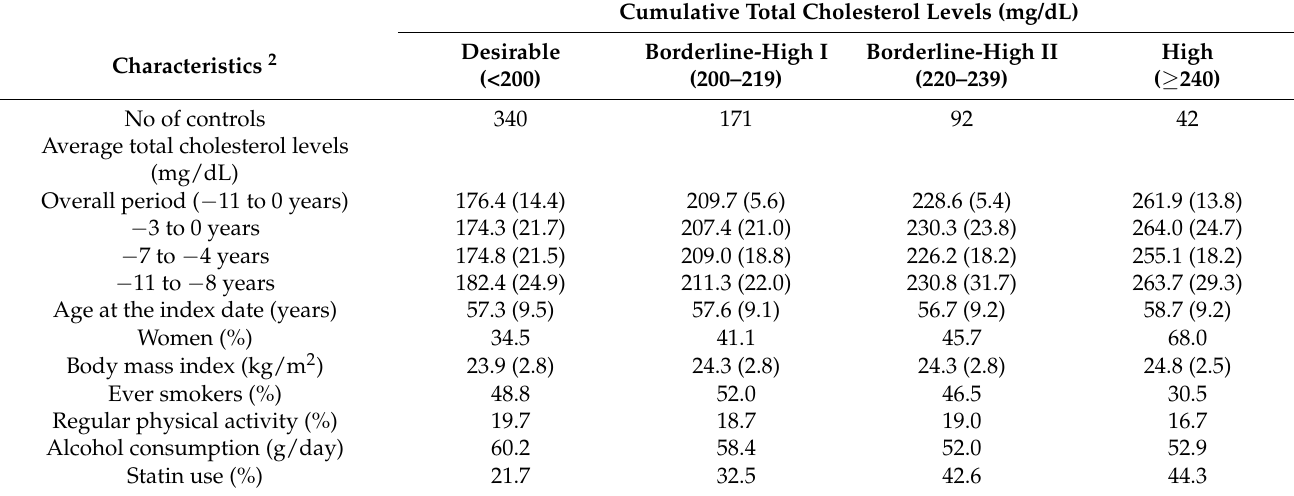
Table 1. Age-standardized cumulatively averaged characteristics of controls by cumulative average of total cholesterol levels over the past 11 years 1